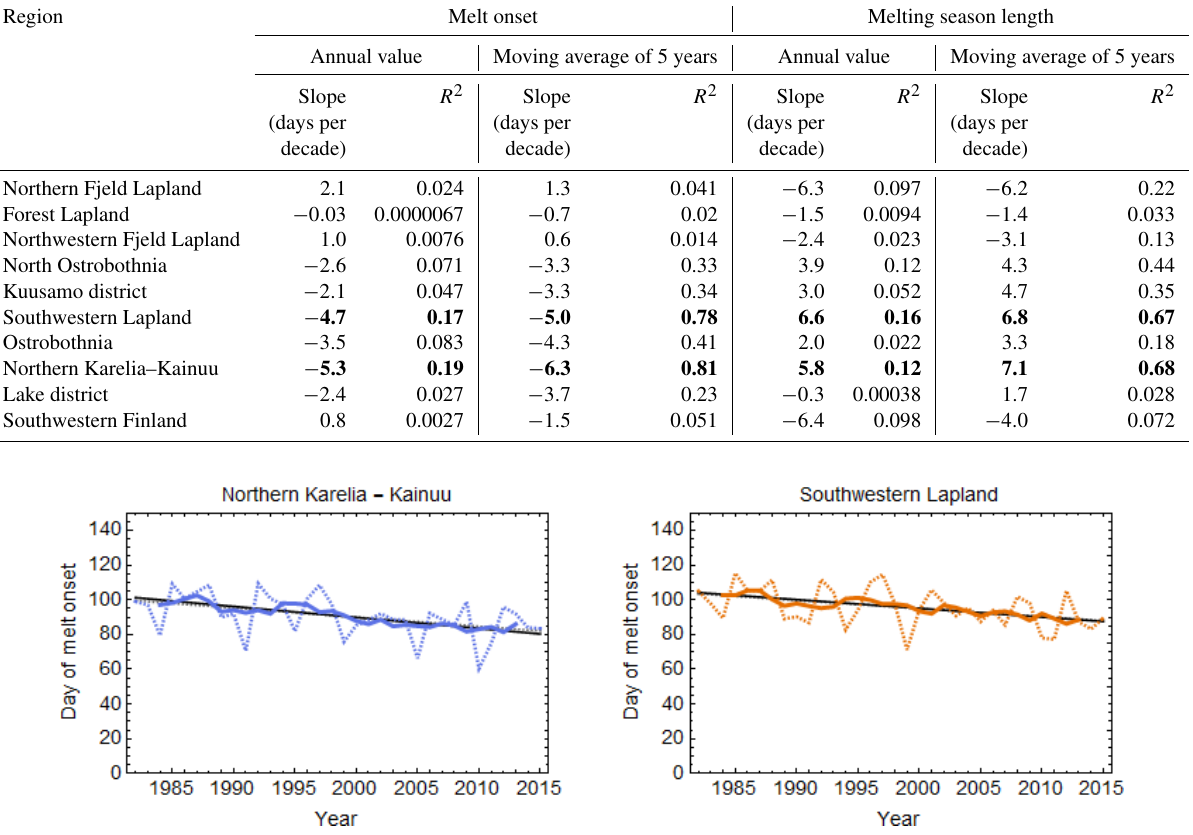
Figure 5. Trends of the melt onset day of the snow cover in Northern Karelia–Kainuu and Southwestern Lapland during 1982–2015 based on the CLARA-A2 SAL product. The solid curves represent the 5-year moving averages and the dotted curves the annual